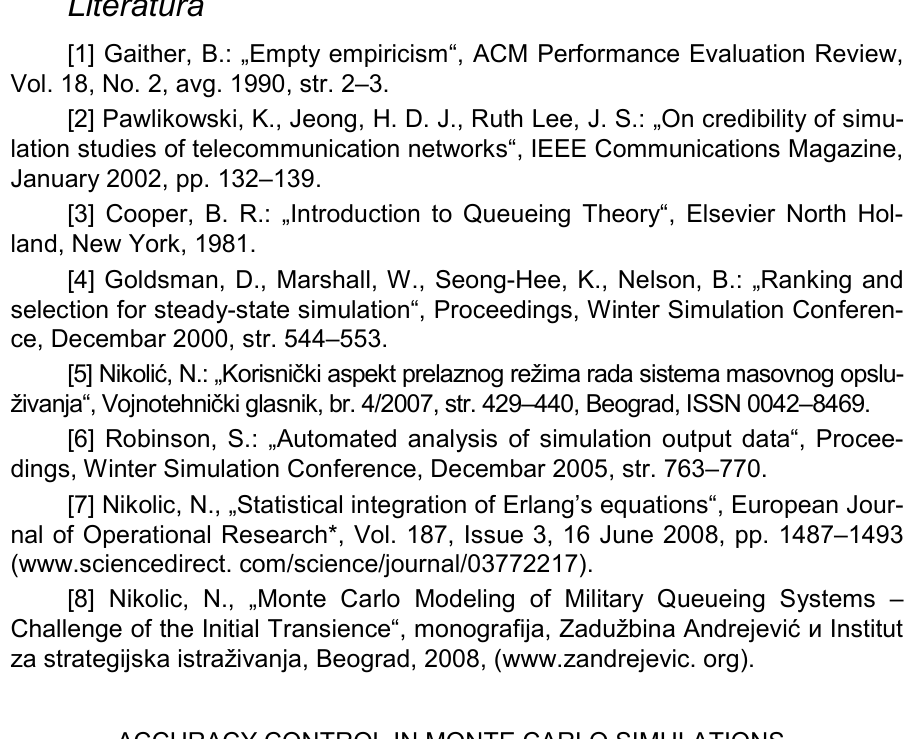
ponavljanja simulacionih eksperimenata, sa prikupljanjem statistike slu- č ajnih procesa“(„Automated Independent Replications with Gathering Statistics of Stochastic Processes“, skra ć eno